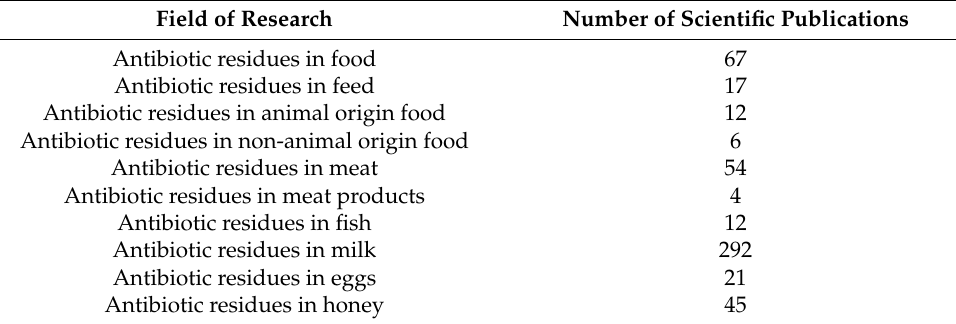
Table 1. Bibliometric analysis according with “Web of Science” database.